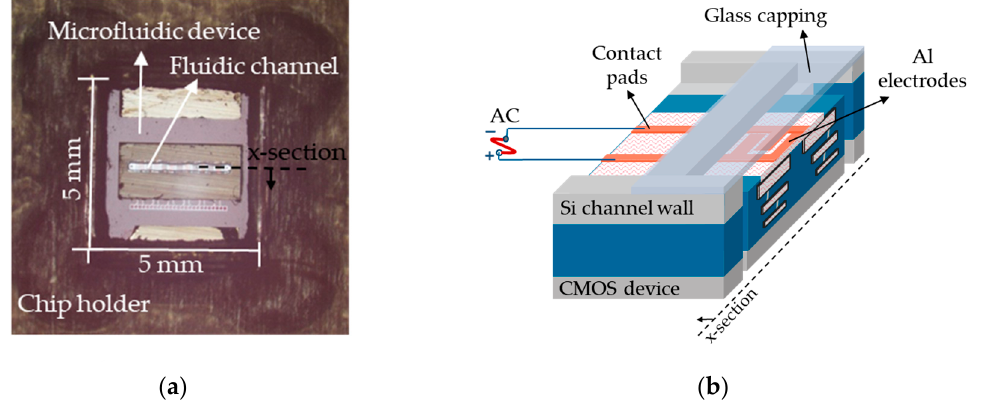
Figure 1. ( a ) Microfluidic device with isolated fluidic and electrical interfaces; ( b ) Schematic cross-sectional view of the device with one IDE structure.